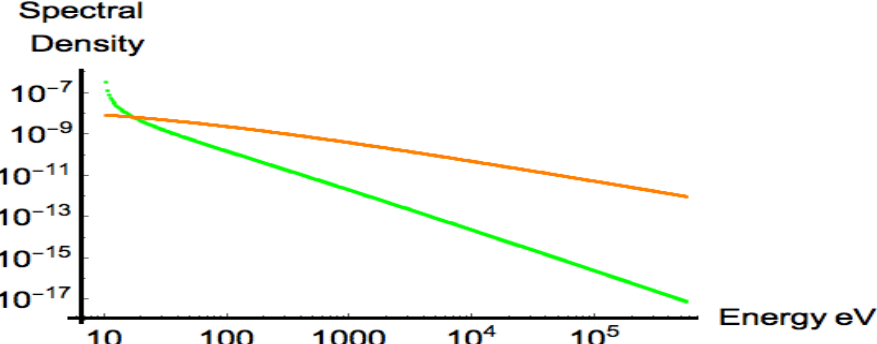
Figure 7. Log-log plot of the absolute value of the spectral density versus the energy for the 2S shift (orange), which goes as 1/ E for large E , and for the 2P shift (green), which goes as 1/ E 2 for large E . At 511 keV, the 2P spectral density is about 5 orders of magnitude smaller than the 2S spectral density. Below 20 eV, the absolute value of the 2P spectral density is greater than the 2S spectral density. Note that the 2P spectral density is actually negative and the 2S spectral density is positive.